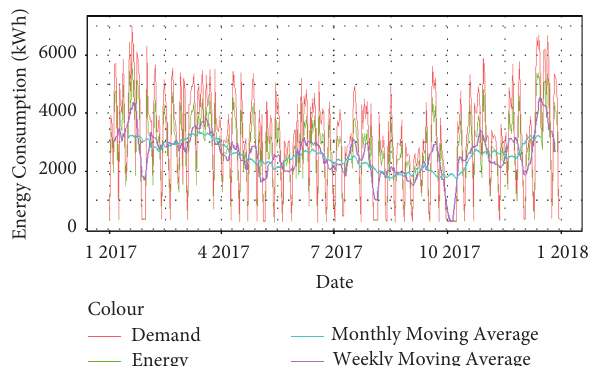
Figure 14: Diagram showing the weekly and monthly moving average of total usages and total demand of energy for the year